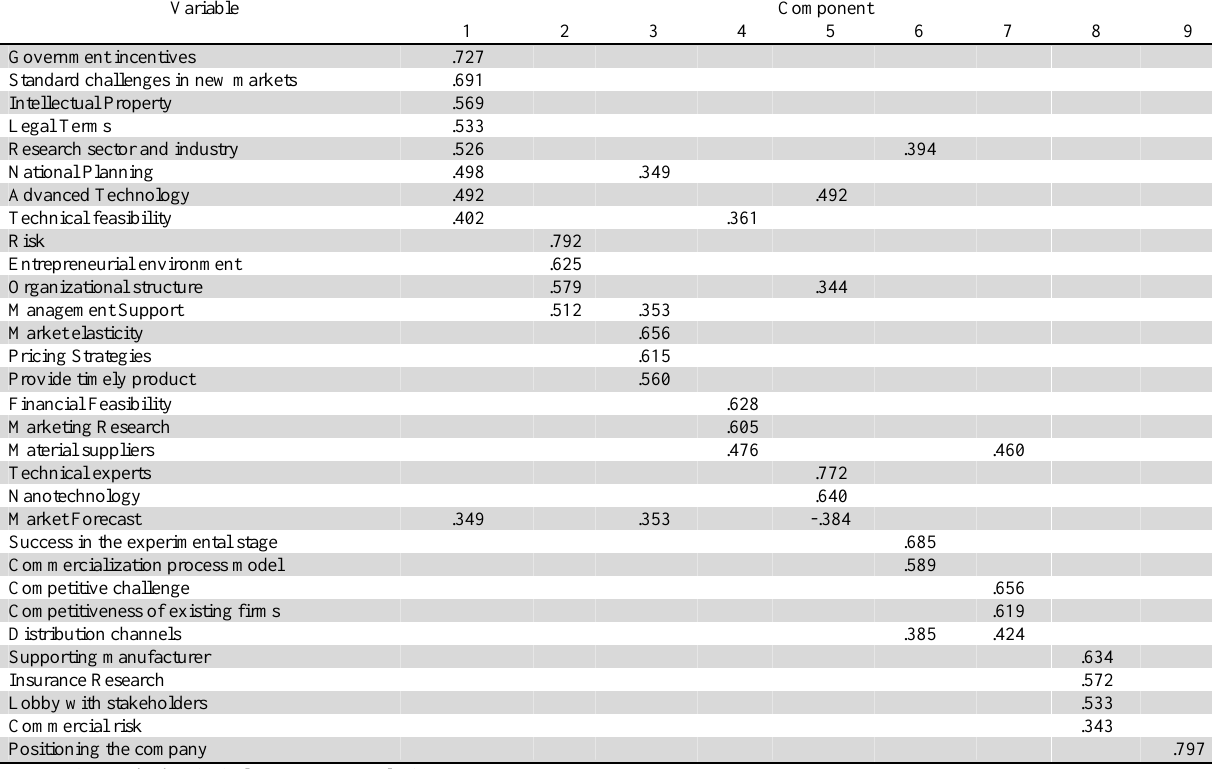
The summary of factor analysis after rotation Variable Government